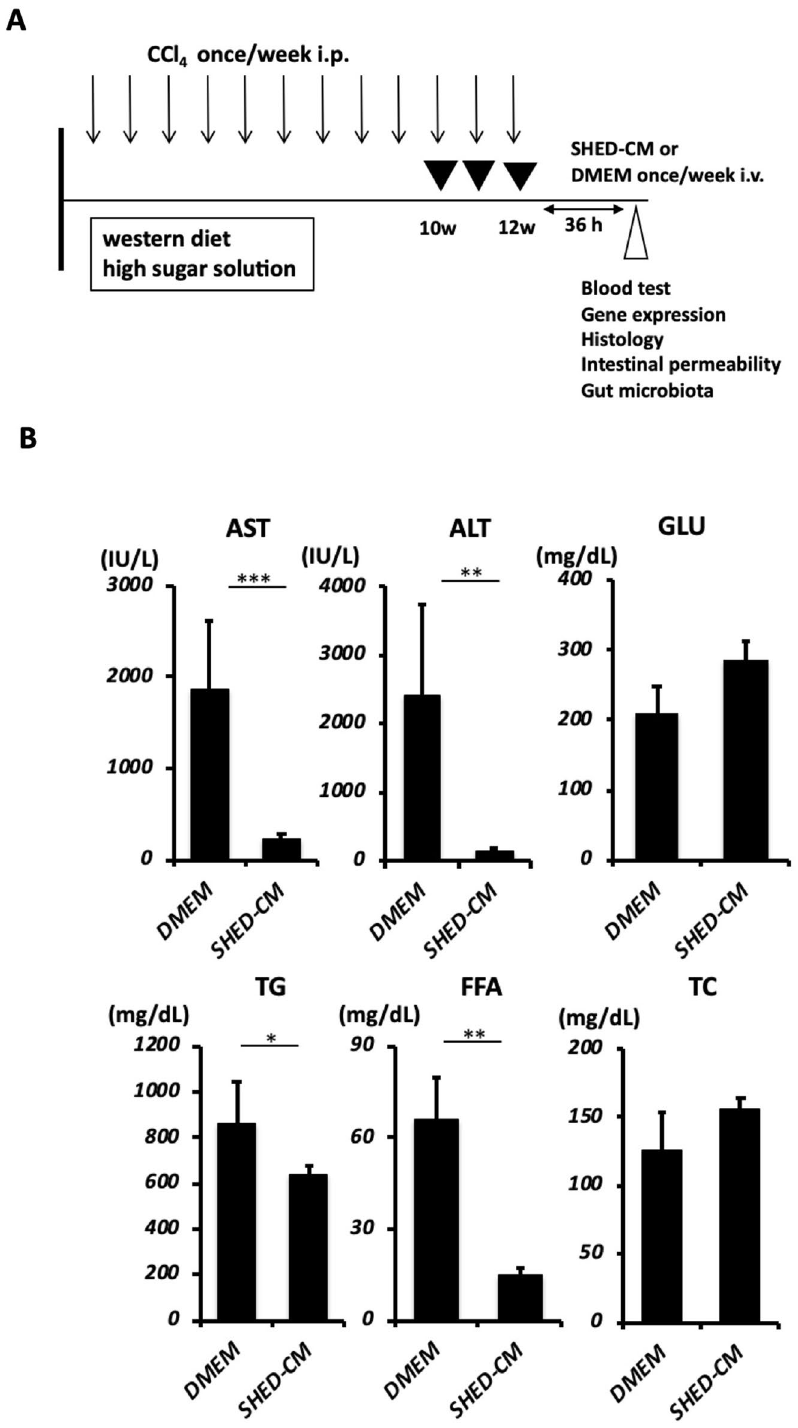
Figure 1. Effects in the peripheral blood of SHED-CM in a murine NASH model. ( A ) C57BL/6 J mice were fed Western diets and a high sugar solution. CCl 4 was injected intra-peritoneally once per week during the course of 12 weeks. From week 10 to 12, SHED-CM or serum-free DMEM was intravenously administered once a week. Blood, gene expression, histological, intestinal permeability, and gut microbiota analyses were carried out at the indicated time points. ( B ) Quantification of concentrations of AST, ALT, GLU, TG, FFA, and TC in the peripheral blood. Data represent mean ± SEM. * P < .05; ** P < .01; *** P < .001. n = 6, DMEM group; n = 8 SHED-CM group. Abbreviations: CCl 4 , carbon tetrachloride; SHED-CM, serum-free conditioned medium from stem cells derived from human exfoliated deciduous teeth; DMEM, Dulbecco’s modified Eagle’s medium; AST, alanine aminotransferase; ALT, aspartate aminotransferase; GLU, glucose; FFA, free fatty acid; TG, triglyceride; TC, total